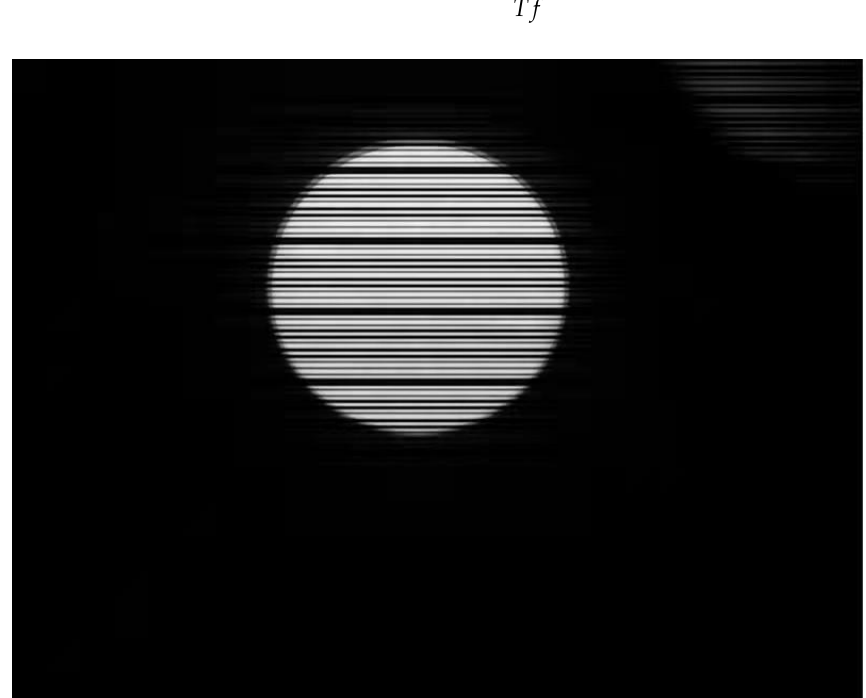
Figure 9. The VLP-LED stripe images with a motion blur length of 12 in